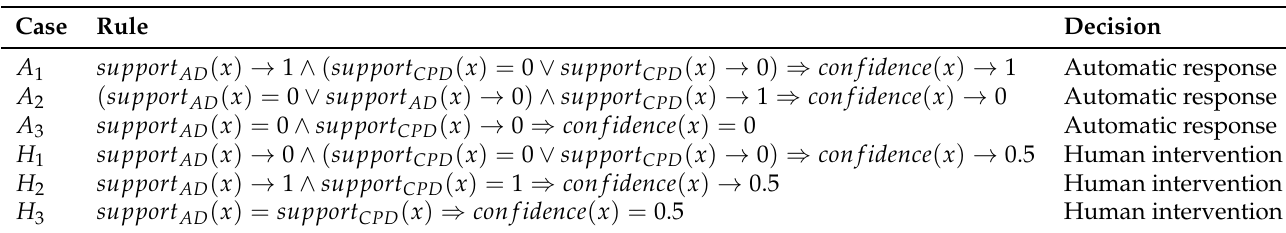
Table 1. Decision